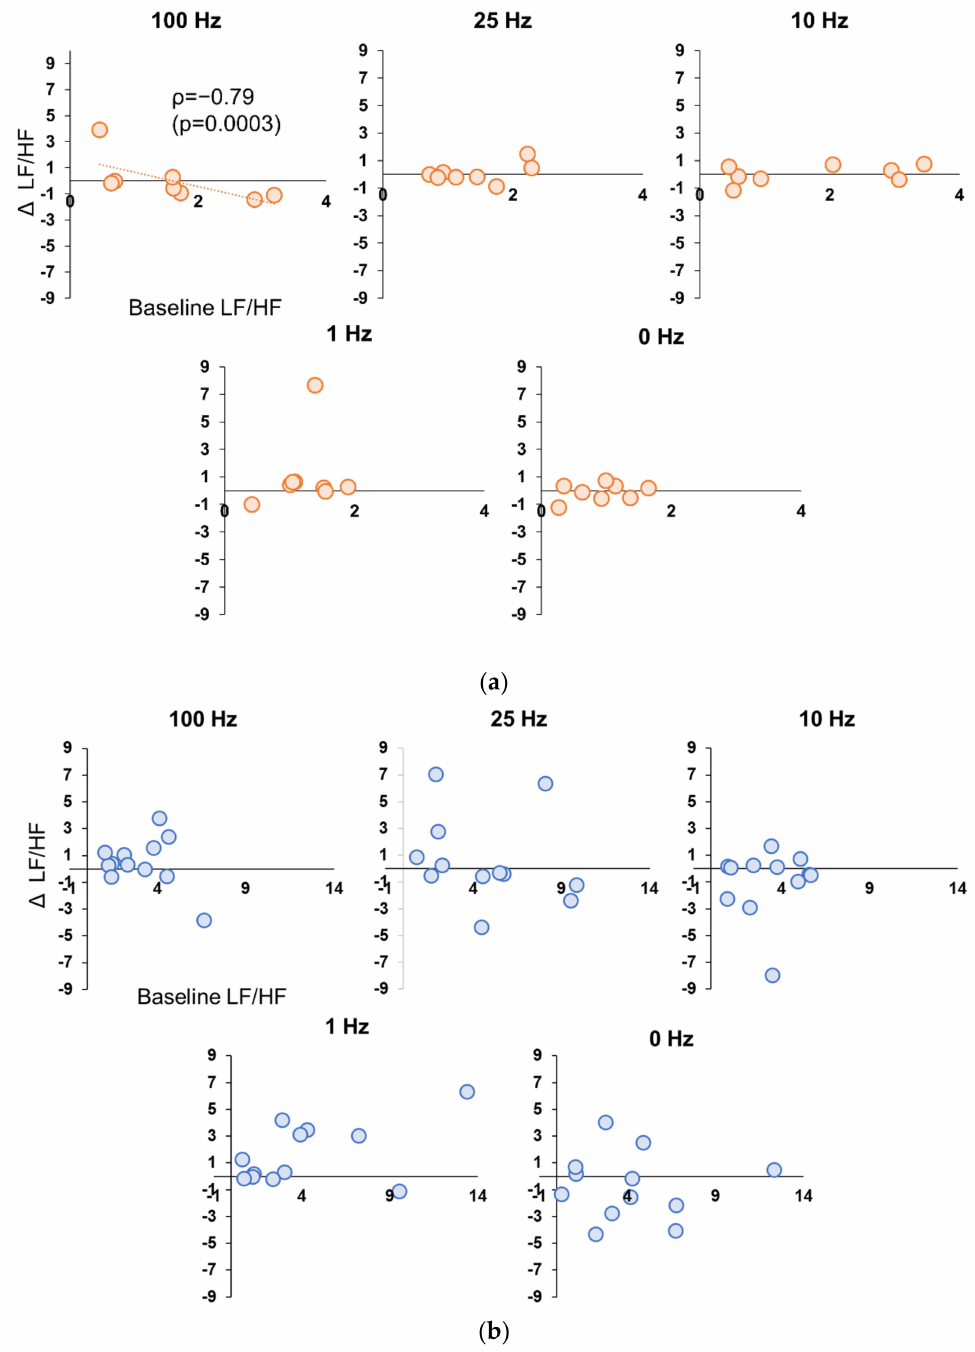
Figure 5. ( a ) Correlation between Baseline LF/HF value and decrement during stimulation period in female participants in Experiment 1. A significant negative correlation was found only for the 100 Hz condition ( p = 0.0003). ( b ) Correlation between Baseline LF/HF value and decrement during stimulation period in male participants in Experiment 1. No significant correlation was found in any of the